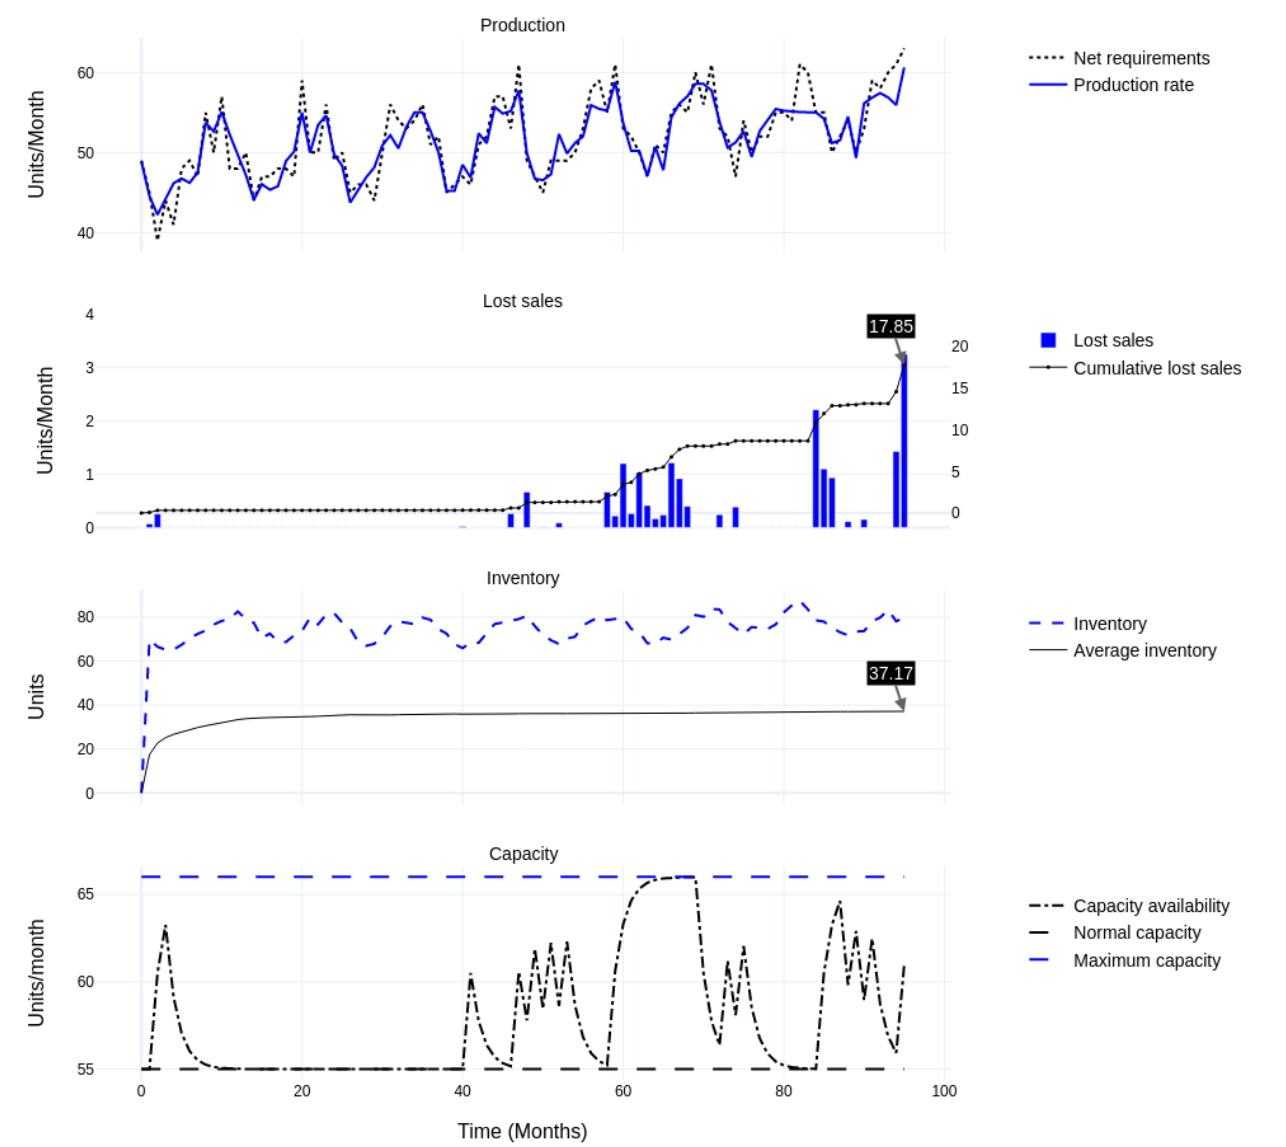
Figure 12. Whole-model simulation results: RNN with discretionary capacity; quick ramp-up and ramp-down.